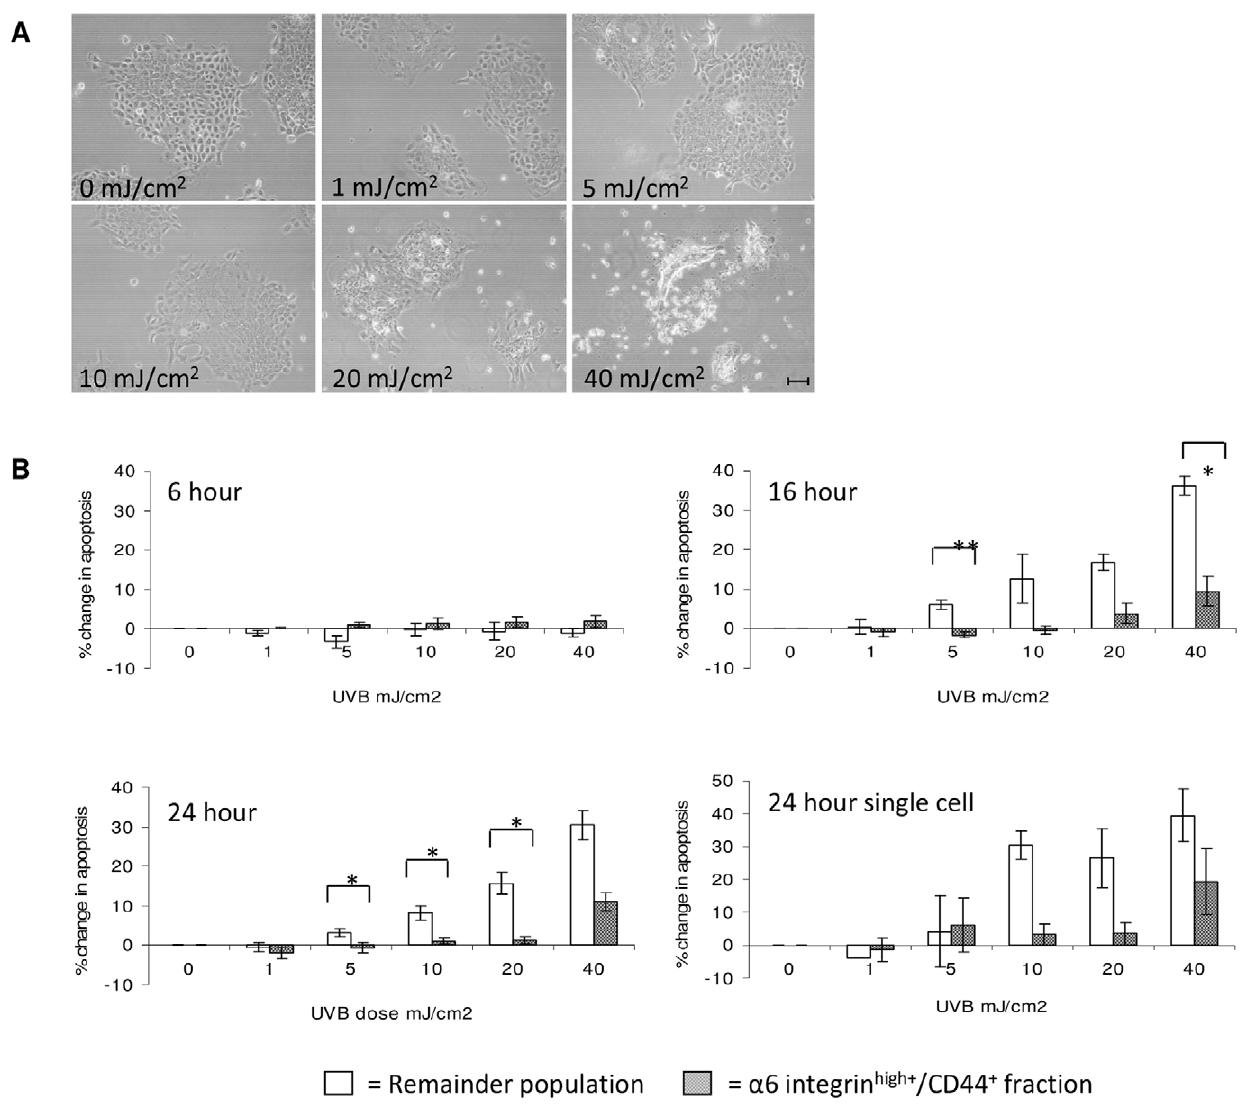
Figure 2. UVB-induced apoptosis. (A) Keratinocytes were grown in culture to form large colonies and photographed 24 hours following UVB irradiation. (B) Quantification of apoptotic cells using flow cytometry. Annexin-V + cells (DAPI + and DAPI 2 ) were totalled in both a 6 integrin high + /CD44 + and remainder populations and plotted as a change in percentage from the control level (0 mJ/cm 2 which averaged , 8% apoptosis) to negate the necrotic cells present before treatment. Results show apoptosis levels 6, 16 and 24 hours after UVB irradiation of colonies at 50% confluency. Keratinocytes were also UVB irradiated as single cells 2 hours after plating, and apoptosis levels are shown after 24 hours. Data represents the mean 6 SEM where n=3. Statistical significance was determined using the paired Student’s t -test **P , 0.01, *P ,